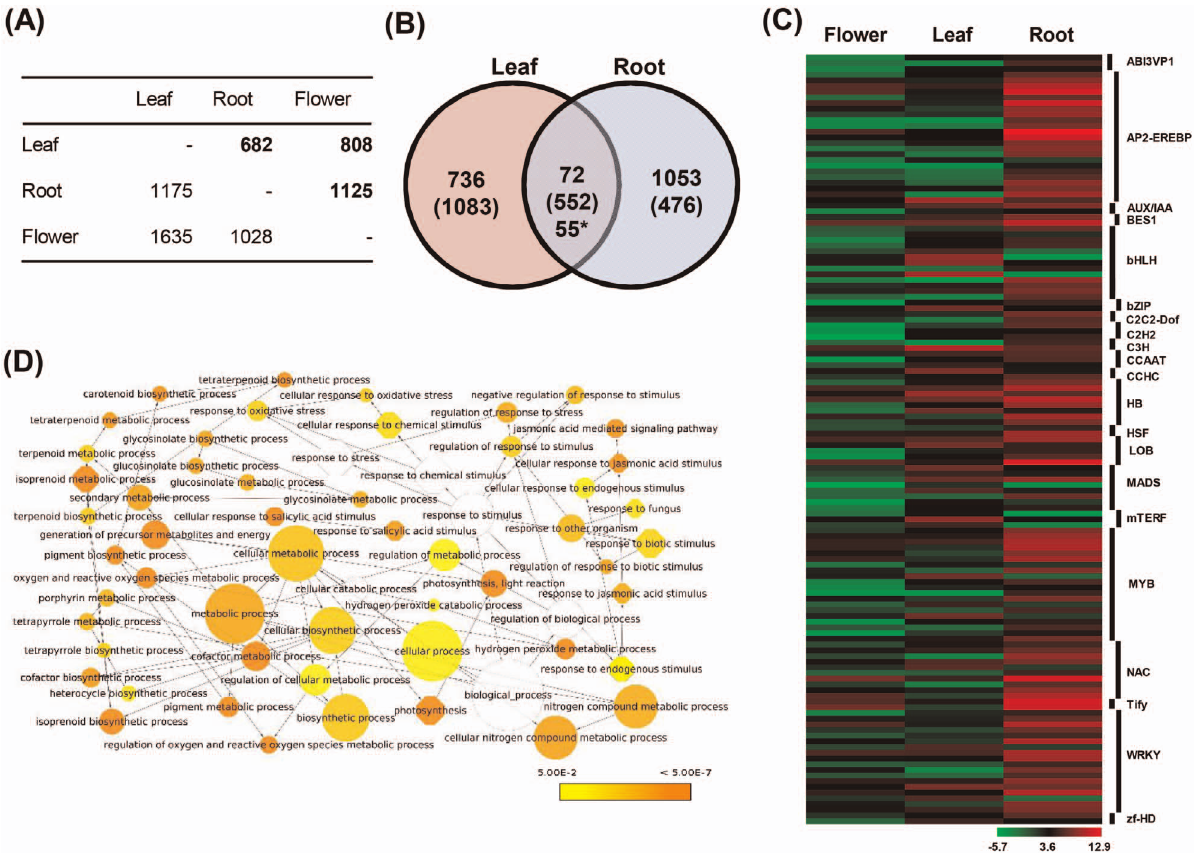
Figure 3. Differential expression analysis of C.roseus transcriptome. (A) Number of differentially expressed genes in different tissues in pairwise comparisons. Number of up-regulated genes are in bold, while down-regulated are in normal font. (B) Venn diagram showing number of up- and down-regulated (in parentheses) genes in leaf and root tissues as compared to flower. Asterisk represents genes up-regulated in one tissue and down-regulated in another tissue. (C) Heat-map showing expression patterns of differentially up-regulated TF encoding genes in different tissues. The scale at the bottom represents log 2 fold change. (D) Graphical view showing GO terms associated with biological process enriched in up-regulated genes of leaf. The GO enrichment was performed using BiNGO. Node size is proportional to the number of genes in each category and shades represent the scale denoting significance level (white- no significant difference).